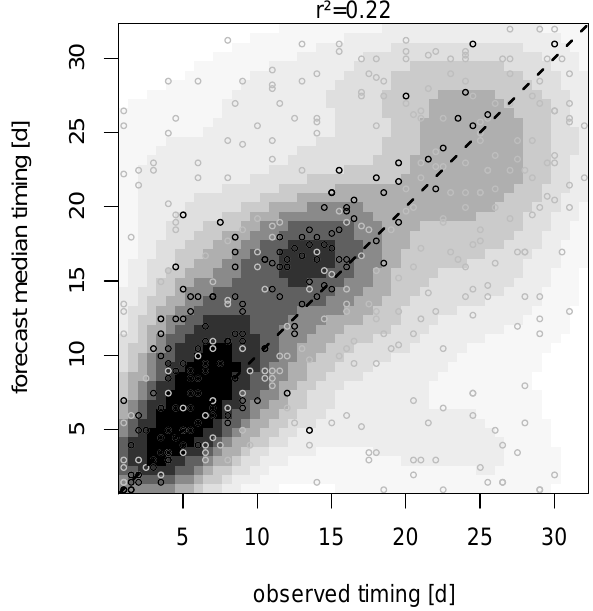
Fig. 11. Observed vs. forecast lead times (median) of streamflow drought events. The center between the onset and offset of an event was chosen as the lead time. The background field is the estimated 2-d density (dimensionless). The black dots mark the events that overlap by at least 1 day with the observed